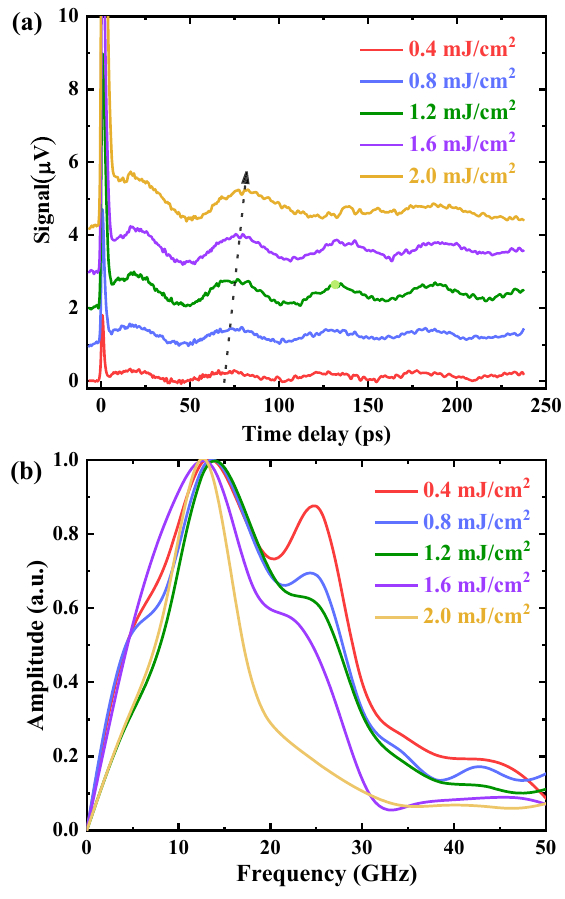
Figure 4: Light induced ion migration monitored with coherent acoustic phonons. (a) Transient reflectivity traces show the Brillouin oscillations at varied pump fluences from 0.4 – 2 mJ/cm 2 . The traces were shifted vertically for a clear vision. (b) The corresponding FFT spectra show the gradual formation of PbI 2 phase at frequency of ∼ 11 GHz and slowly disappearing of PbI 2 -poor phase at frequency of ∼ 25